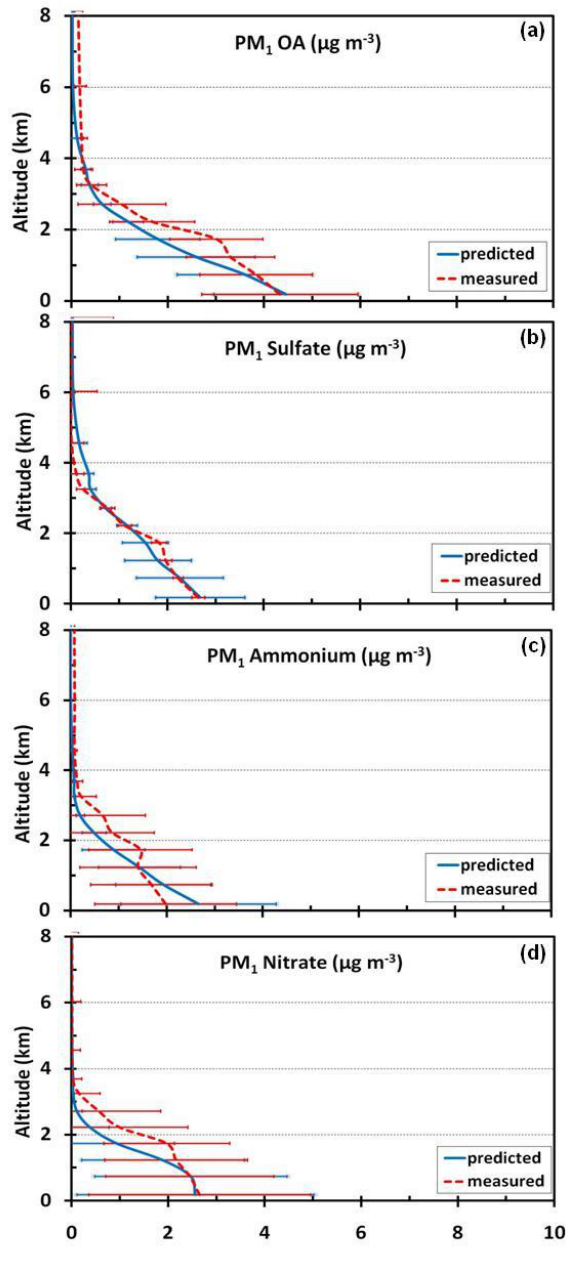
Fig. 18. Comparison of predicted (PMCAMx) vs. observed (AMS) vertical profiles of aerosol chemical composition averaged over the entire EUCAARI-LONGREX campaign for PM 1 (a) organics, (b) sulfate, (c) ammonium and (d) nitrate. The horizontal bars indicate one standard deviation for each 500m altitude bin mean